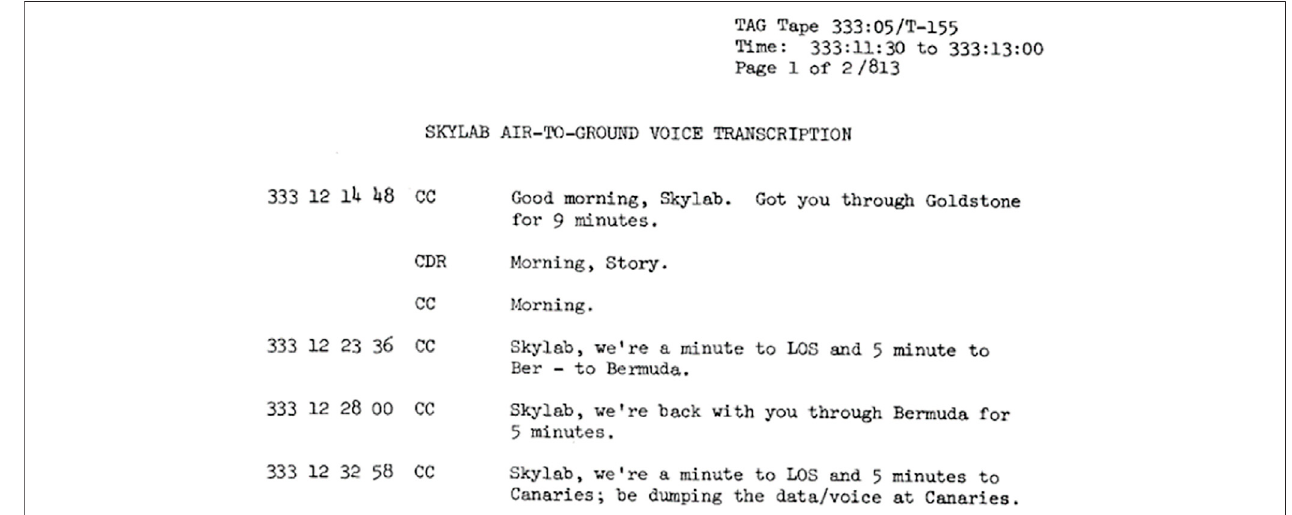
FIGURE 7 | NASA excerpt 2 — a “ mundane ” call to